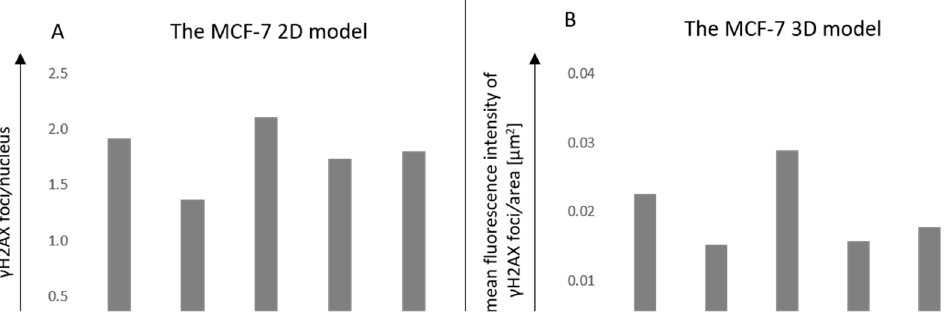
Figure 12. The quantification of the mean fluorescence intensity of the γ H2AX foci after cell exposure to 2 Gy and dose of 2 Gy with the previous 50 min incubation with AuNPs in the 2D model ( A ) and 3D model ( B ).